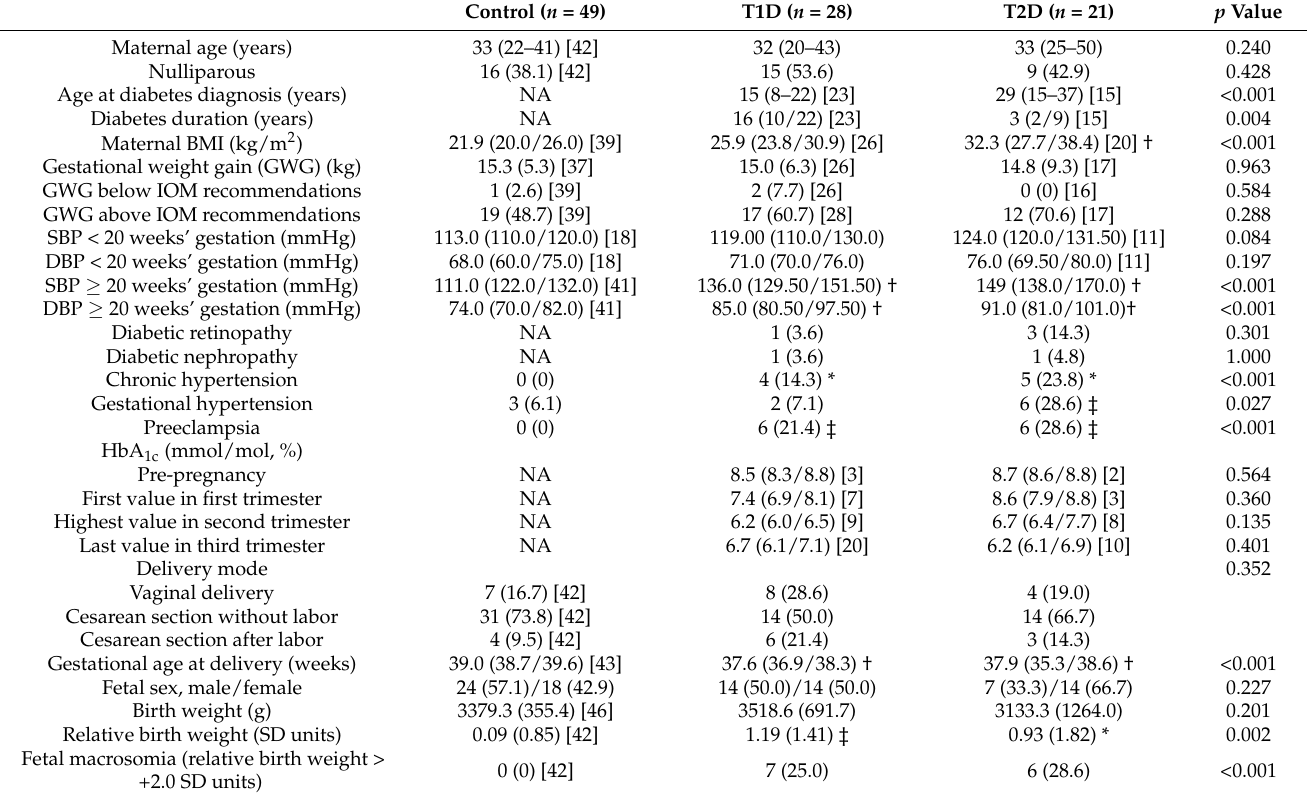
Table 1. Maternal and perinatal characteristics of women with type 1 and type 2 diabetes and controls with non-diabetic